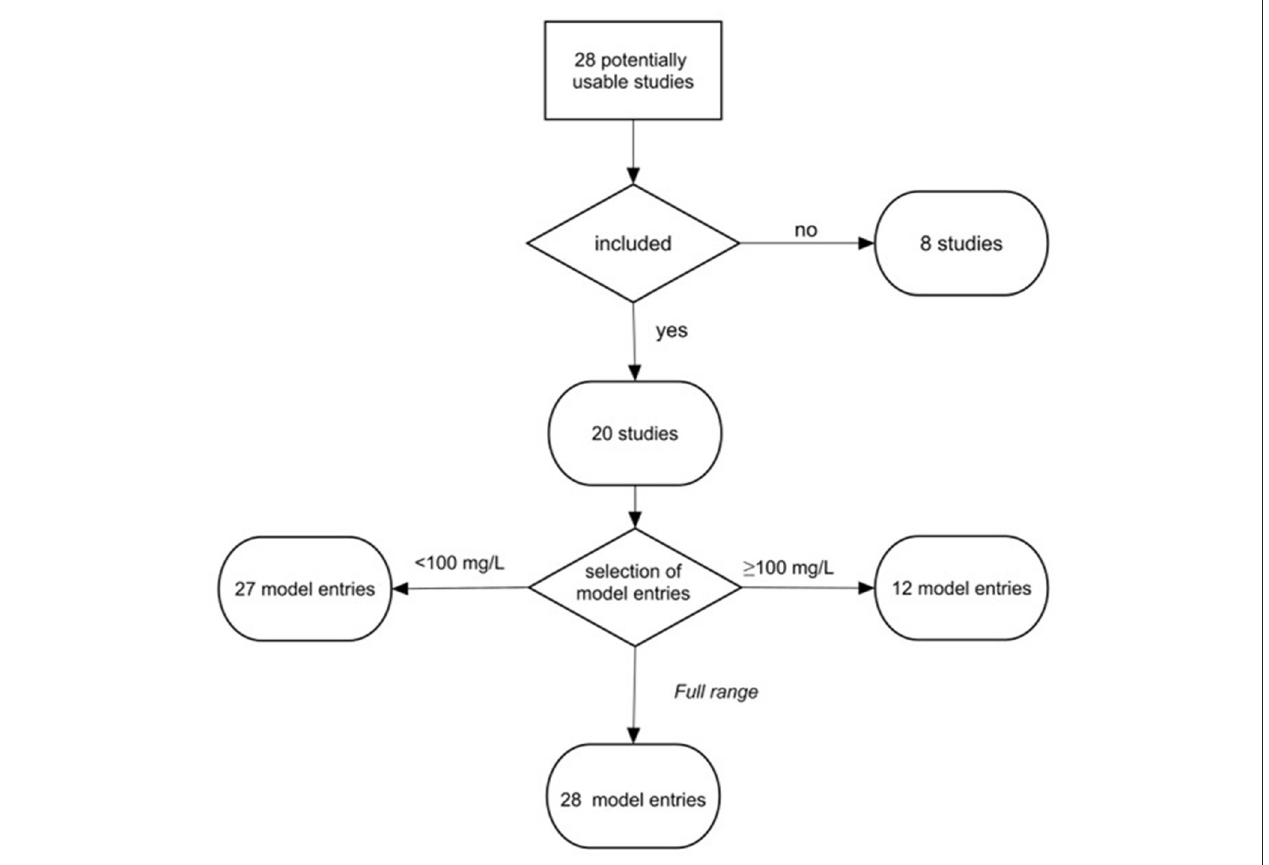
FIGURE 1 | Workflow for data selection and grouping. To investigate effects at the low and high levels of MNP in the tests, the studies were assigned to three models: Low concentration model ( < 100 mg/L), High concentration model ( 100 mg/L), and Full range model (0.004–1,100 mg/L). The threshold of 100 mg/L was used ≥ following the recommendations for suspended solid concentrations in stormwater ( U.S. EPA,